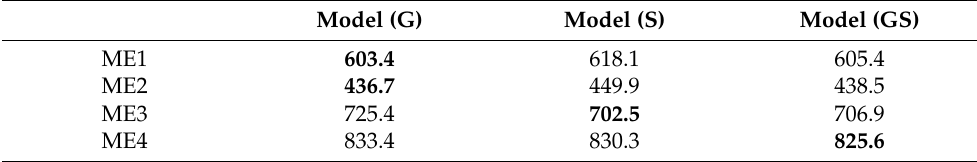
Figure 1. Small flagellates carbon content ( µ g L − 1 ) during ( a ) ME1, ( b ) ME2, ( c ) ME3 & ( d ) ME4. The average of the 3 treatment replicates are plotted against time with standard deviation as error bars. There is no error bar for ME3 as there were only 2 replicates per treatment from day 6. Note the different vertical scales. Table 4. DMSP concentration AICs from models (G), (S) and (GS) for the 4 mesocosms. The model providing the best fit is the one with the lowest AIC (in bold). The (G) model fits a common trajectory regardless of treatment, while the (S) and (GS) models incorporate treatment